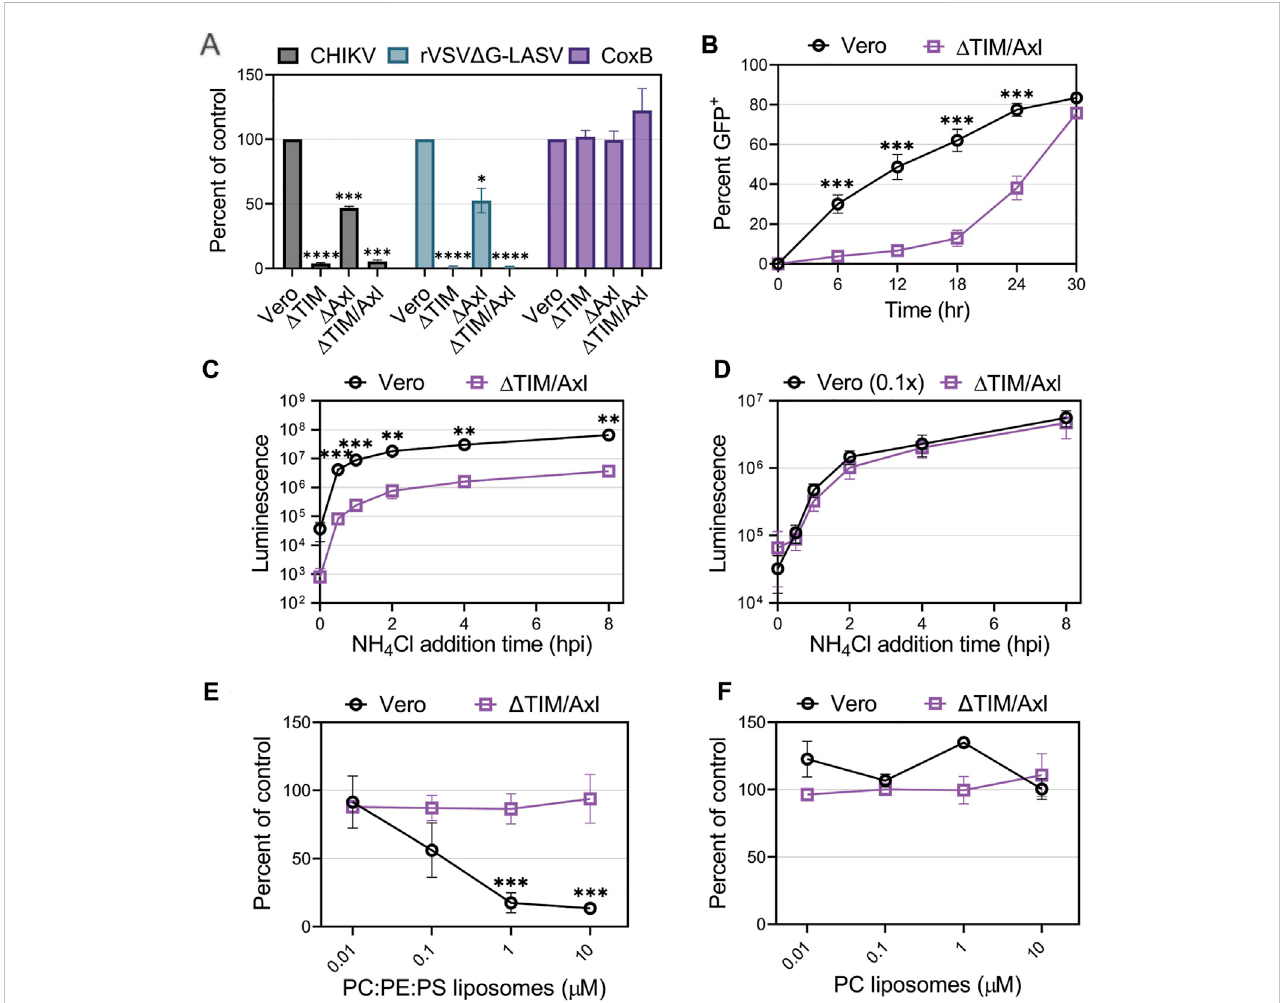
FIGURE 4 EntryofCHIKVintoVerocellsismediatedmainlythroughTIM-1. (A) EntryofCHIKV-Nluc,rVSV Δ G-LASV-Nluc,andCoxBintoVero,Vero Δ TIM,Vero Δ Axl, andVero Δ TIM/Axlafteroneroundofreplicationwasassessedbyluciferaseassaysorcellviability(CoxB). (B) Luminescencevaluesfromtheknockoutcellswas compared to the values observed in the parental Vero to determine the percent of control. CHIKV-GFP cellular spread kinetics were quanti fi ed by fl ow cytometry and the percent of GFP + cells over time in Vero and Vero Δ TIM/Axl cells. Kinetics of endosomal escape of CHIKV was determined by infecting Vero and Vero Δ TIM/Axl cells with (C) equal amounts of virus or (D) 10-fold less virus in Vero cells. Cells were treated with NH 4 Cl at the indicated time points and luminescence was measured 8 h post-infection. The ability of (E) PS-containing liposomes (75% PC: 20% PE: 5% PS) and (F) PC-only liposomes, to block CHIKV infection into Vero Δ TIM/Axl, cells was assessed at the indicated concentrations. The data for each respective panel were generated at the same time and in the same way as the data displayed in Figure 3. We present the Vero data from Figure 3 again to allow for easy visual comparison to the Vero Δ TIM/Axl data. Unpaired parametric Student ’ s t-test was performed to determine statistical signi fi cance with unequal variance comparing PC:PE:PS to PC